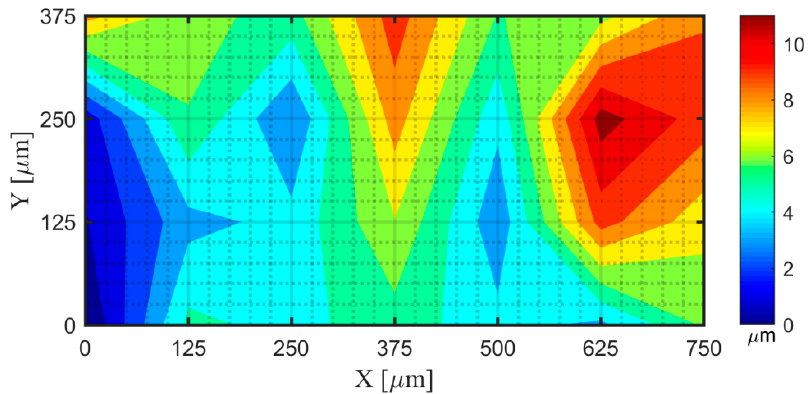
Figure 21. Contour of the Euclidean residuals between each certified and corrected points.